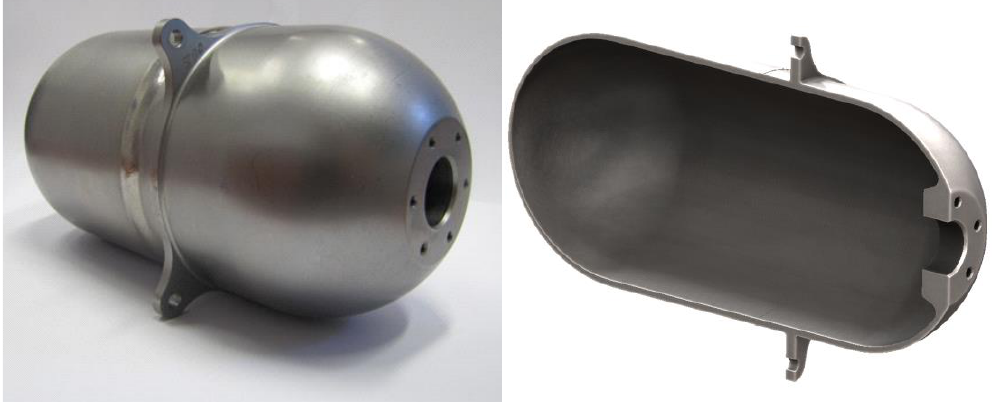
Figure 4. Photograph of the Adelis-SAMSON propellant tank ( left ) and illustration of a cross section view of the Adelis-SAMSON propellant tank ( right ).